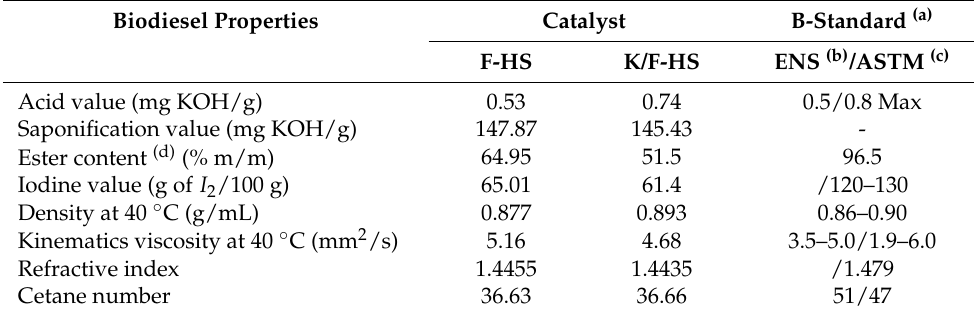
Figure 5. N 2 adsorption-desorption isotherms of fusion hydrothermal F-HS zeolite and ion ex- change-modified K/F-HS zeolite.